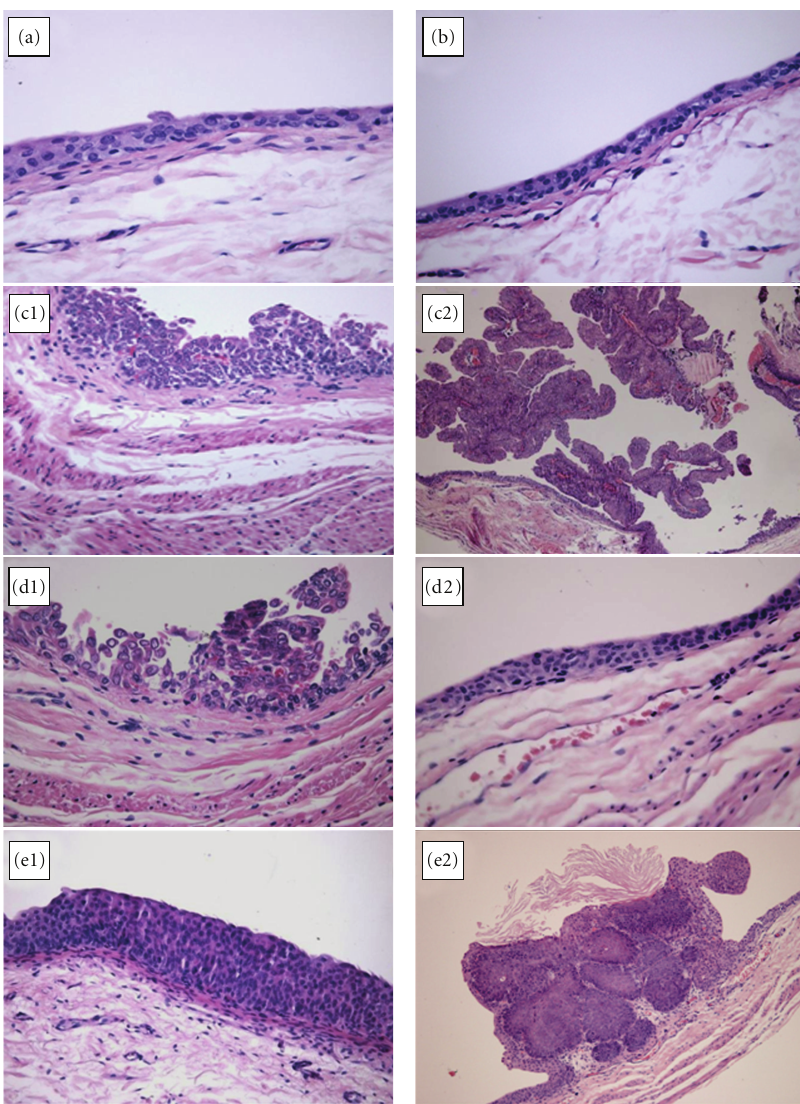
Figure 2: Microscopic histomorphological evaluation of bladder urothelium. The bladder from control (a) and CEL (b) treated rats had no signs of preneoplasic lesions (neither hyperplasia nor dysplasia) or gross tumor formation. In the carcinogen (BBN) group (c), the bladder from all the animals presented hyperplasia and high-grade dysplasia (c1), including those without tumor formation, as well as malignant lesions, mainly papillary tumors (c2), but also infiltrative and CIS. In the preventive CEL+BBN-P treatment (d), only one bladder of the 8 rats presented tumor formation with dysplasia (d1), while all the other rats have presented a normal urothelium profile (d2), contrasting with the pattern found in the curative CEL (BBN+CEL-C group) use (e), which reveals preneoplasic, including high-grade hyperplasia and dysplasia (e1), and neoplasic lesions, even more malignant (e2) (H&E staining